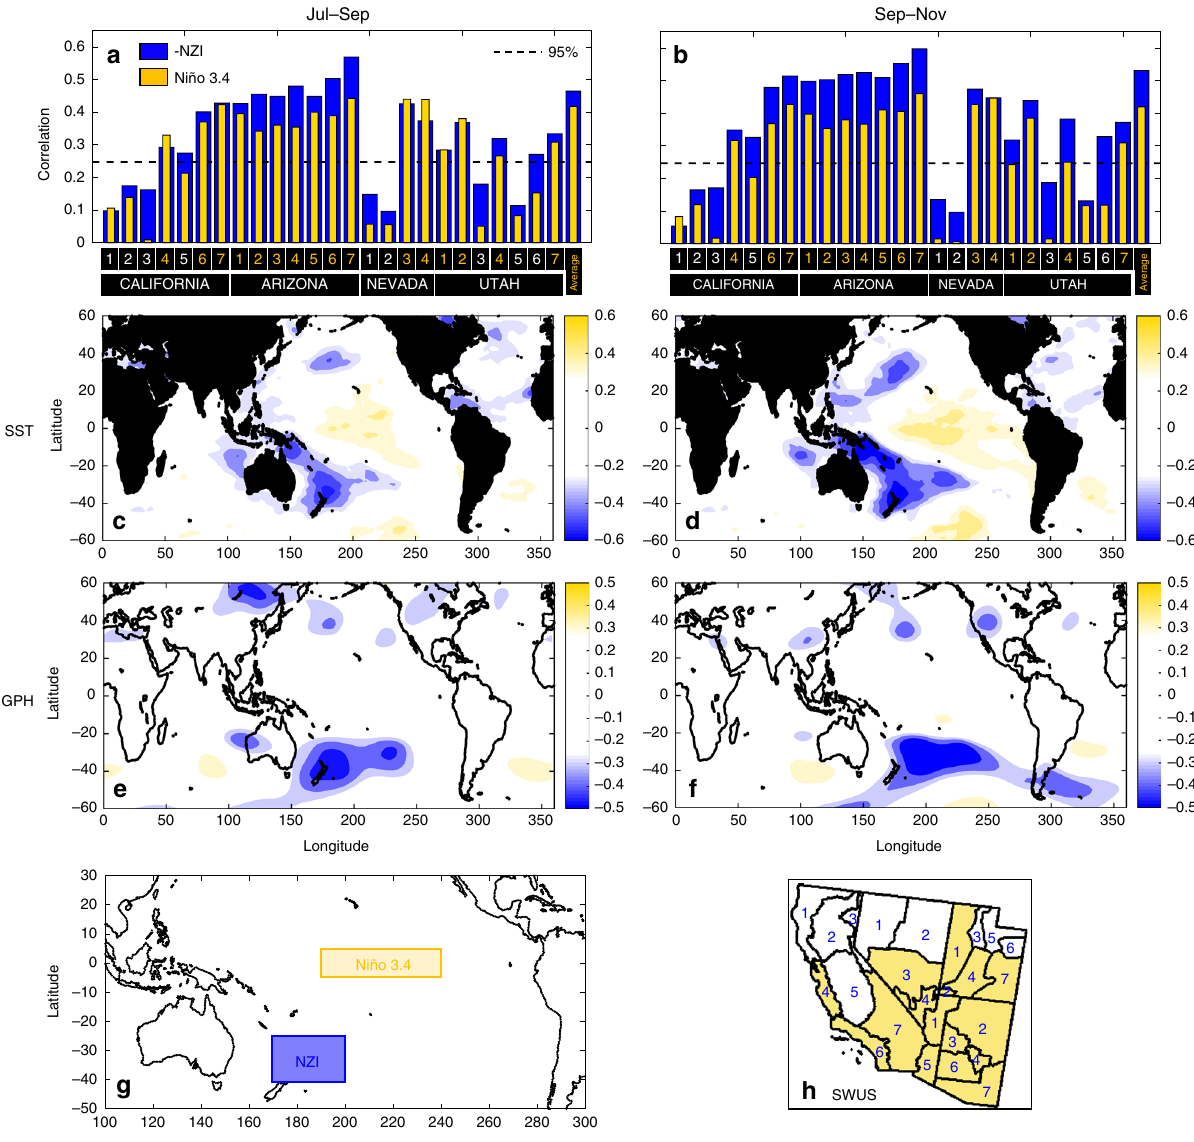
Fig. 1 Evidence for a new teleconnection in the southwestern Paci fi c. a , b Correlation coef fi cients of – NZI and Niño 3.4 with winter precipitation (Nov – Mar) for all climate divisions of southwestern US (SWUS) and for two different periods (Jul – Sep and Sep – Nov) for 1950 – 2015. Average precipitation is de fi ned as the area-weighted average precipitation amount over climate divisions where Niño 3.4 exhibits statistically signi fi cant correlation (see colored numbers in panels a , b , and regions in panel h ). c Correlation map between SST (Jul – Sep) and the average winter precipitation in SWUS for 1950 – 2015. White color indicates statistically insigni fi cant correlations ( α = 0.05 signi fi cance level); d Same as c , but SST is averaged over Sep – Nov; e , f Correlation maps as in c , d , but using GPH (400 mb). The emergence of a persistent correlation pattern in the southwestern Paci fi c (coined as the New Zealand Index, NZI) is robust for both SST and GPH; g the location and areal extent of NZI and Niño 3.4; h The selected climate divisions in SWUS (in color), for deriving the regionally averaged precipitation amount, based on their signi fi cant correlation with Niño